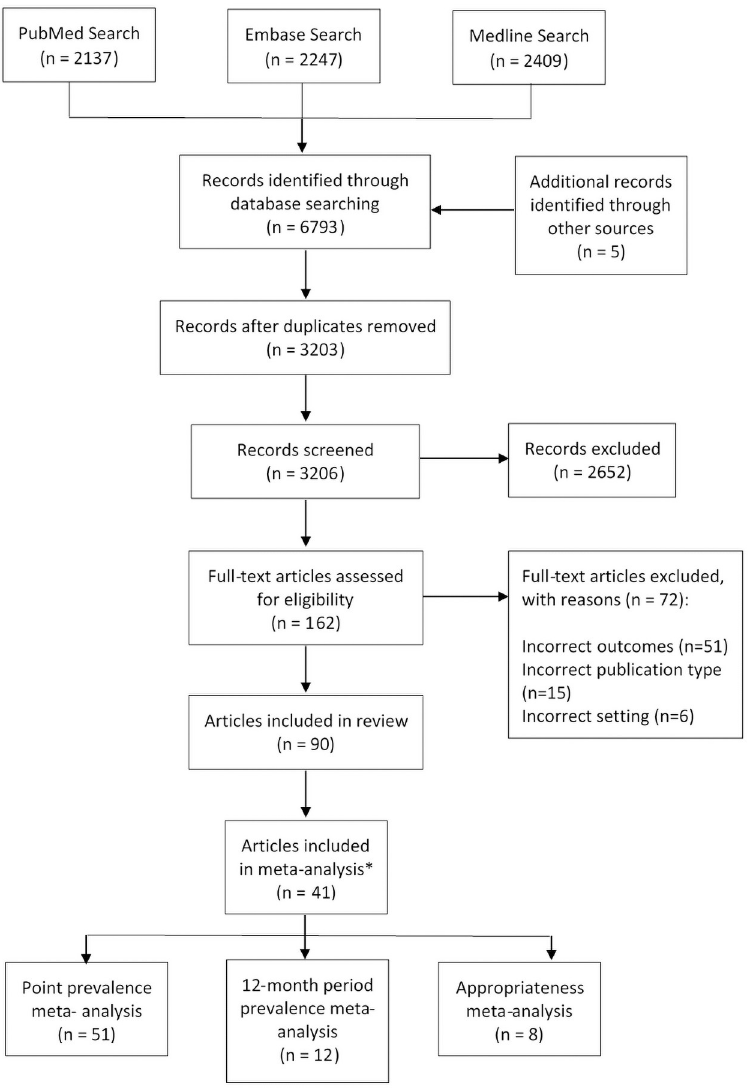
Fig 1. Flowchart of search strategy and screening results. � Some studies contributed more than one estimate to the meta-analyses.